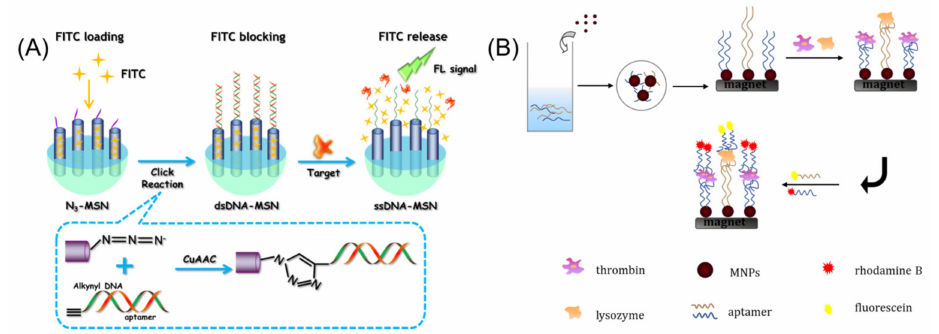
Figure 2. Schematic representation of fluorescent sensors for thrombin detection. ( A ) The thrombin detection sensor based on aptamer controlling FITC release from mesoporous silicon nanoparticles. Adapted with permission from Ref. [63]. Copyright (2017), Elsevier. ( B ) Magnetic nanoparticles assisted sensors for simultaneously detecting thrombin and lysozyme. Adapted with permission from Ref. [66]. Copyright (2009),